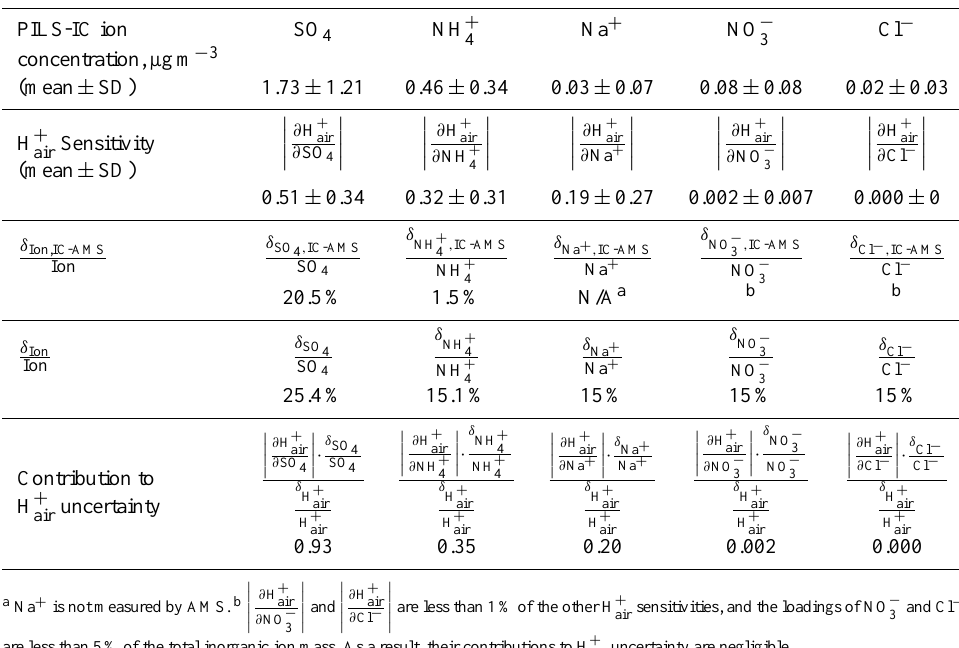
Table 2. Sensitivity of H + to ions from ANISORROPIA (second row) and contribution to uncertainty. Uncertainties of inorganic ions ( δ Ion air are calculated based on a combination of PILS-IC instrumental relative uncertainties (IC uncertainty, referred to as to be 15%) and the difference between PILS-IC and AMS ( r (cid:16) δ (cid:17) 2 (cid:16) δ (cid:17) 2 δ Ion ion,IC Ion,IC-AMS = + (fourth row). Contribution of uncertainty is the ratio of ion uncertainty over H + Ion Ion Ion calculated to be 14% in Eq. 8) (fifth row).